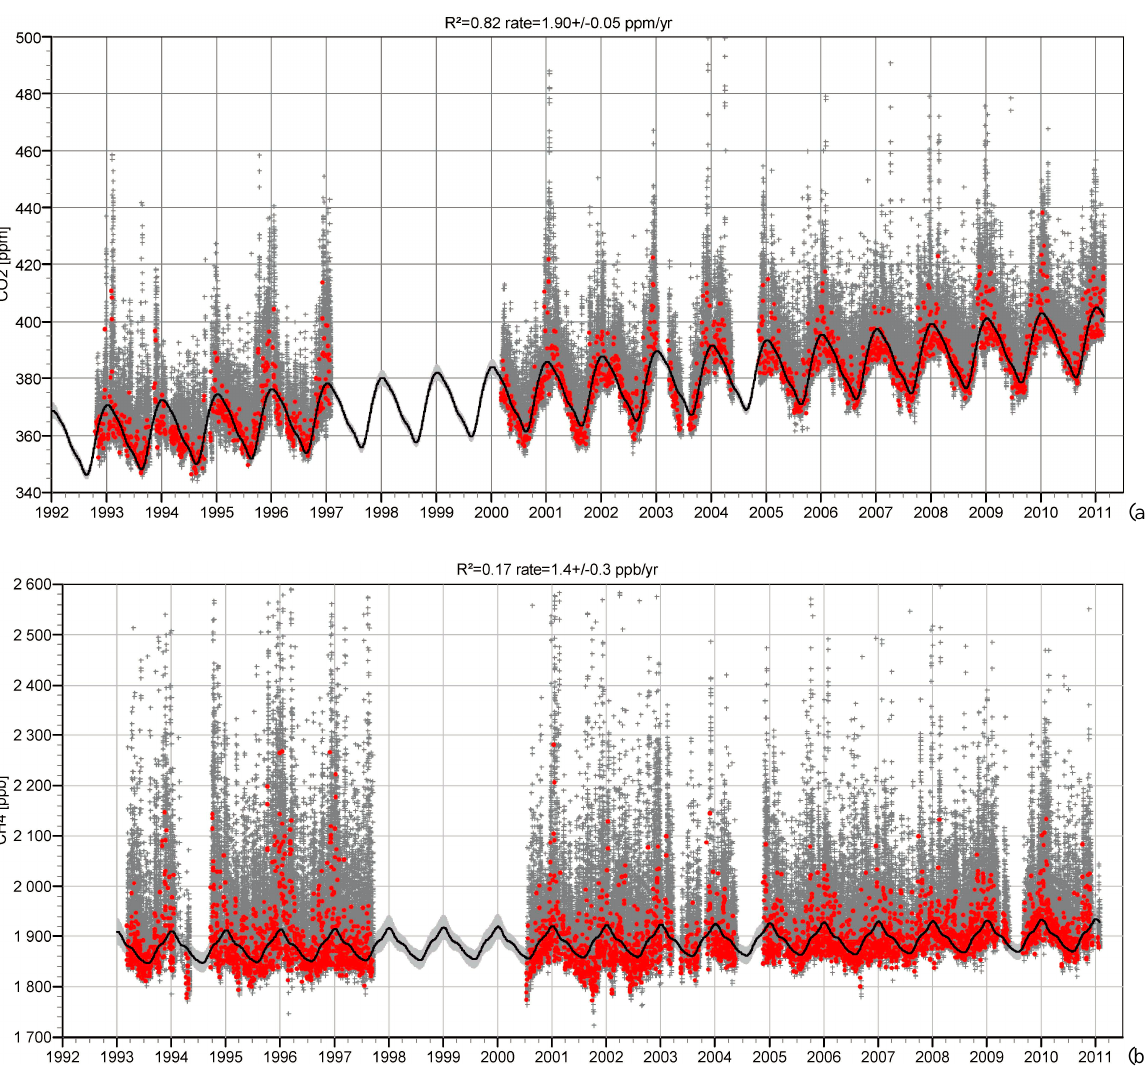
Fig. 9. Time series (1992–2011) of CO 2 (a) and CH 4 (b) at Cabauw 200ma.g.l.: all values (dark grey crosses), daily CO 2 minima or daily CH 4 25%-trimmed minimum values (coloured dots), fitted harmonic function (black line, methods C resp. A; see Sect. 4.4) and confidence interval for the harmonic fit, computed from the standard deviation of the daily values (light grey area), see also section 4.5 and Table